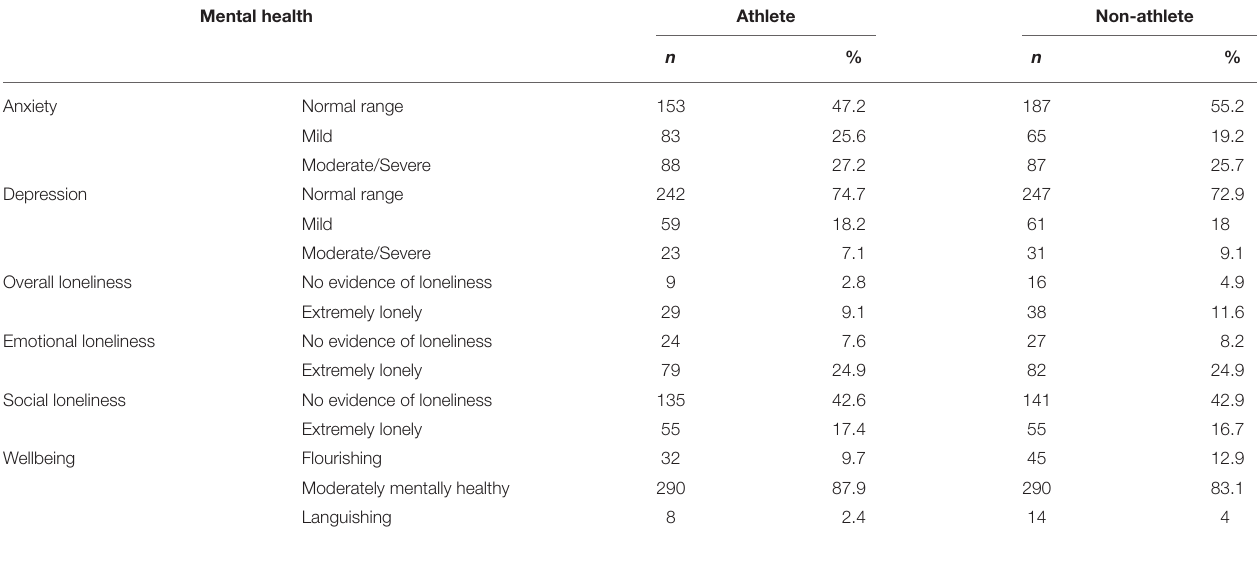
TABLE 1 | Descriptive statistics for the severity of anxiety and depressive symptoms, and the rate of flourishing, languishing, and extreme loneliness in athletes and non-athletes. Mental